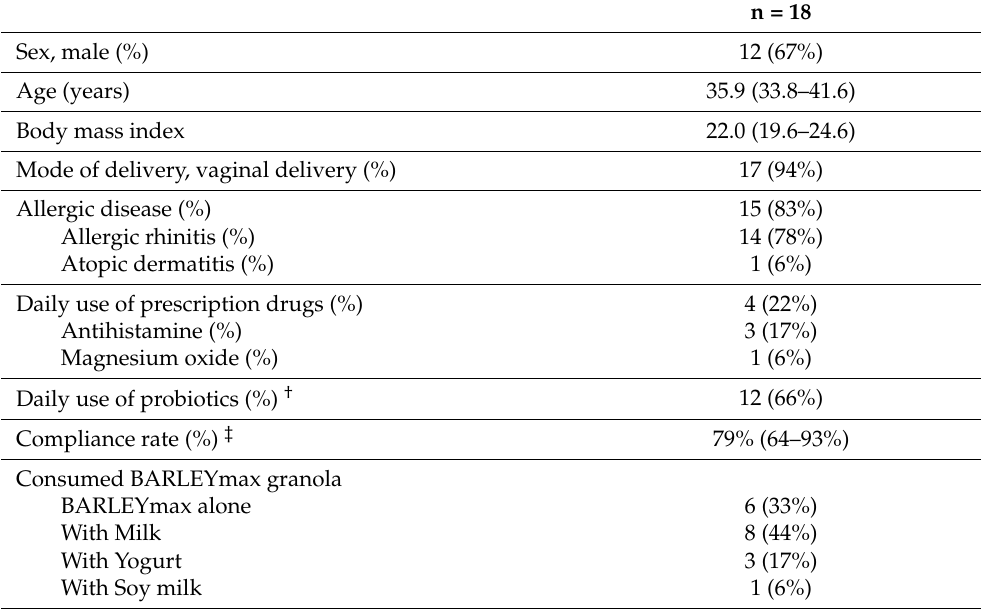
Table 1. Characteristics of